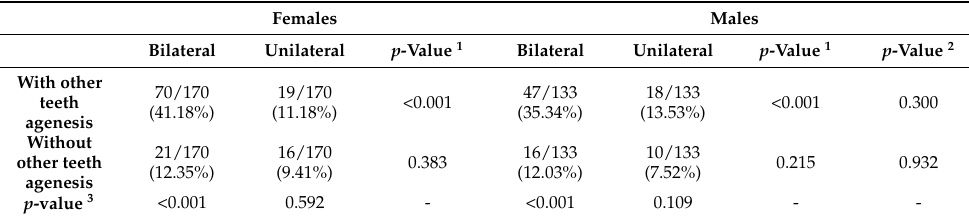
Table 3. Incidence of bilateral versus unilateral third molar agenesis in individuals with and without agenesis of teeth other than the third molars. Females Males Bilateral Unilateral p -Value